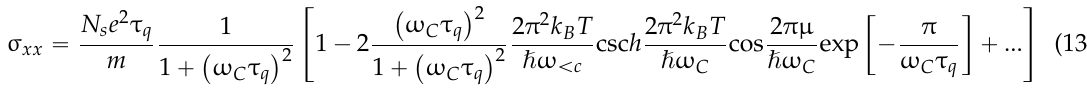
Figure 11. Experimentally measured and calculated SdH oscillations. Measurements of d σ /dB were carried out at T = 380 mK. Calculations were performed by applying Equation (13).